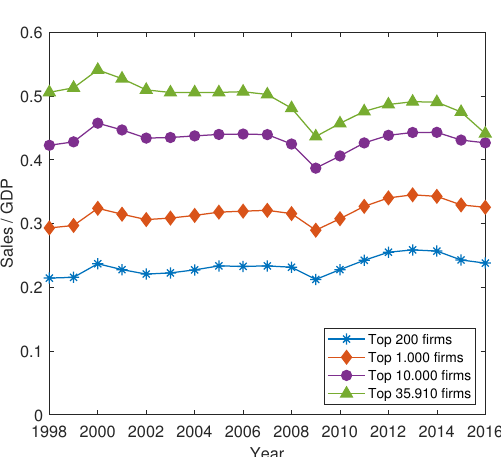
Figure A1. Sales as a function of GDP for the largest long-lived firms in our sample.